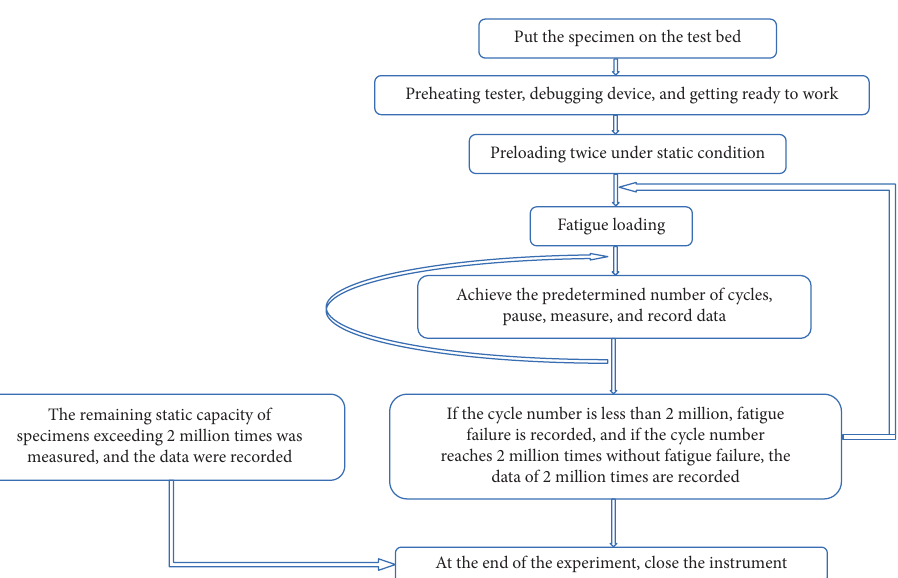
Figure 2: Test procedure for fatigue